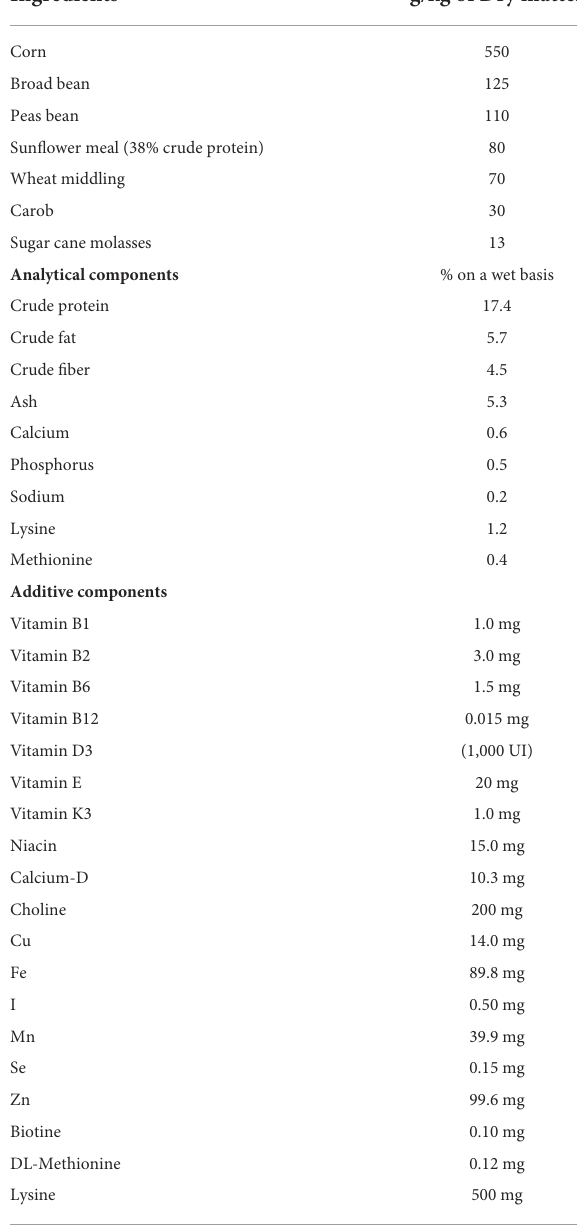
TABLE 1 Ingredients and composition of the pelleted complete feed.